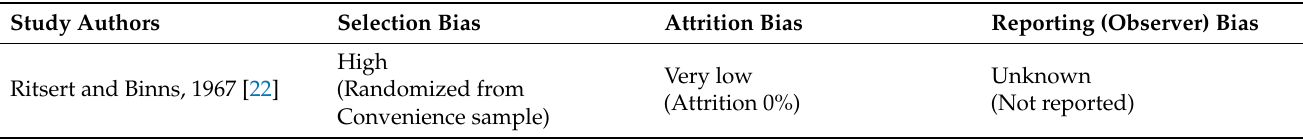
Table 3. Potential bias of all pediatric inclusion